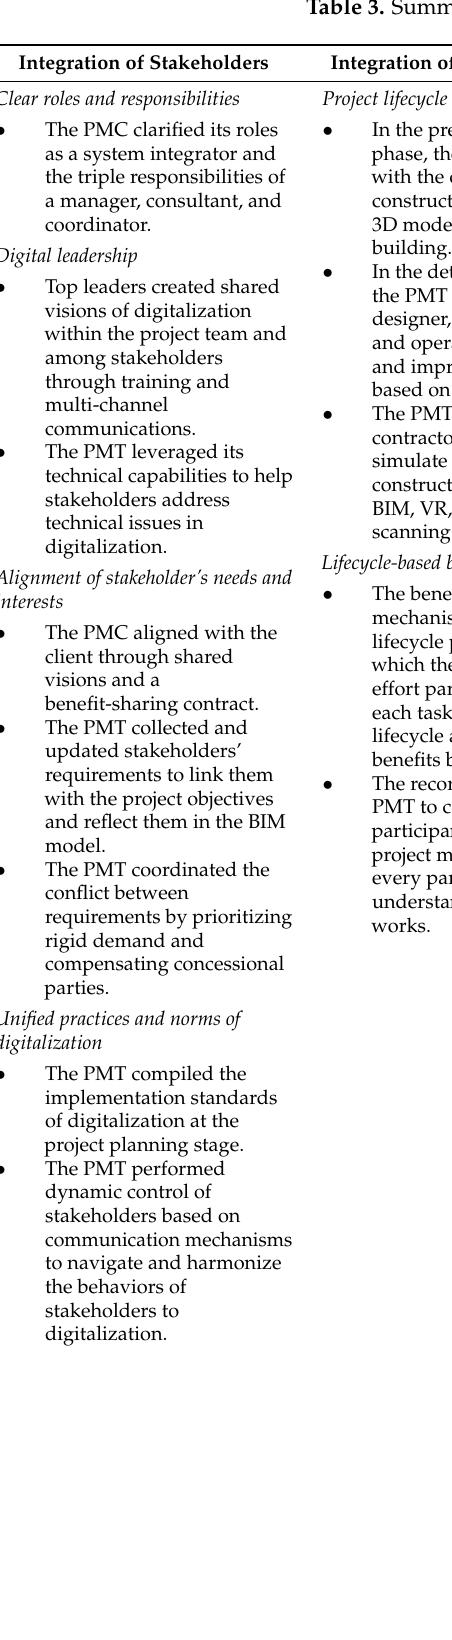
Table 3. Summary of case study